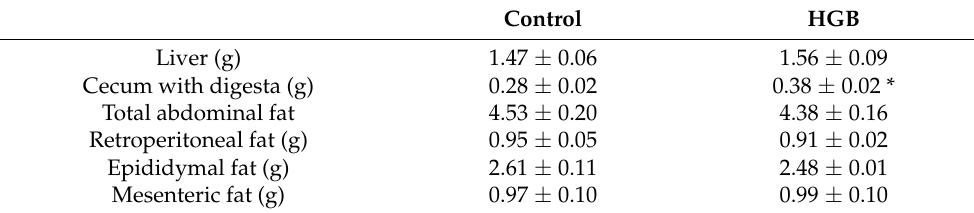
Table 4. Weight of organs.